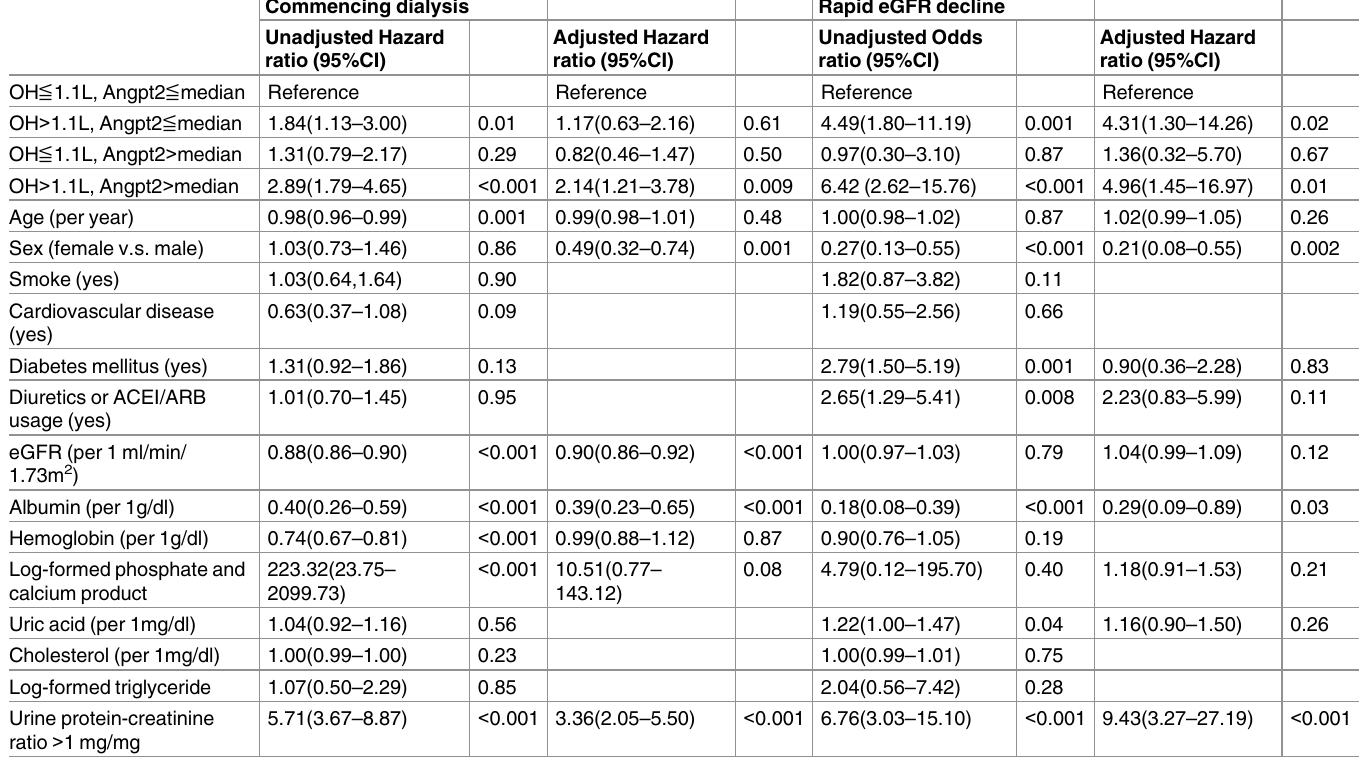
Table 4. The adjusted risks for commencing dialysis and rapid eGFR decline according to fluid status and circulating angiopoietin-2 (Angpt2)